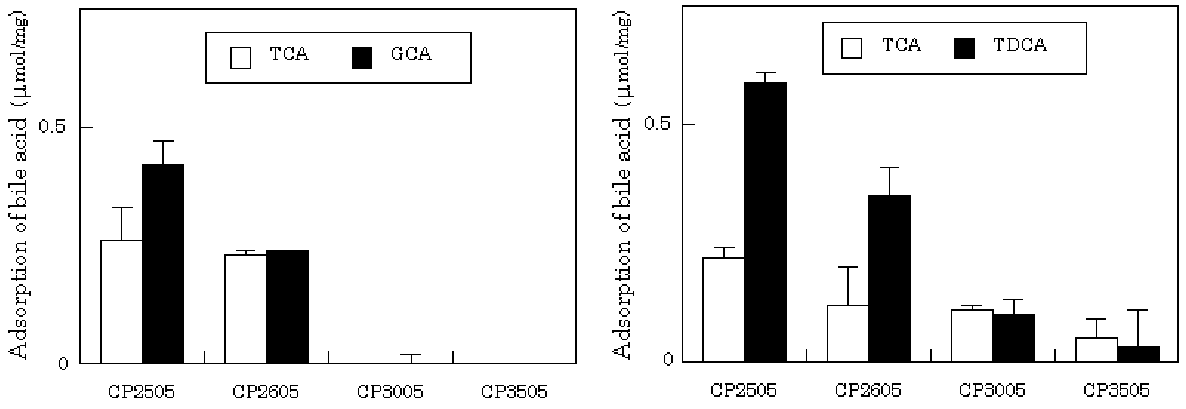
Figure 1. Adsorption of BAs by CP-CMP.